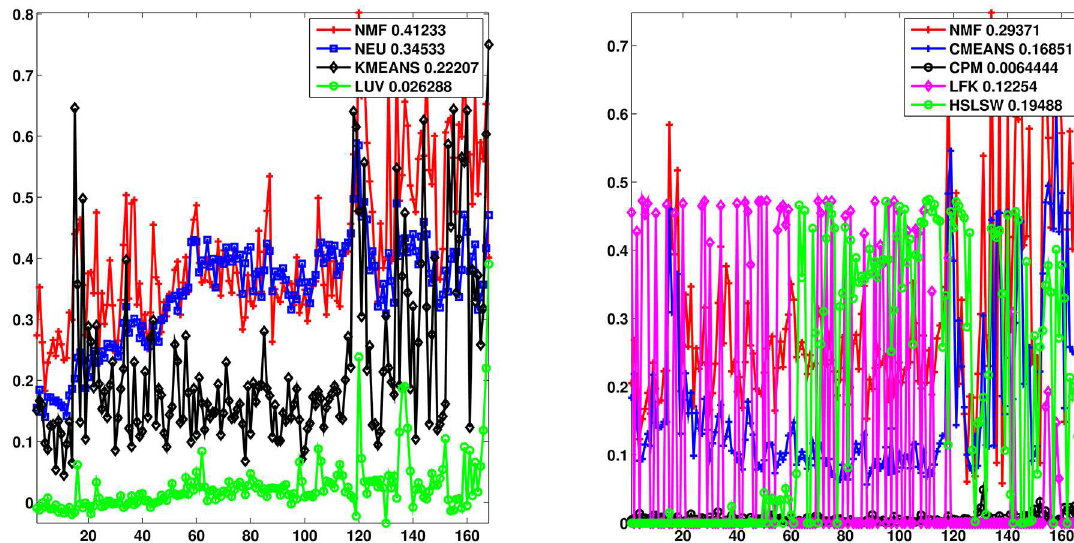
Fig 6. The modularity comparison with different algorithms. The modularityof different algorithms for hard (a) and soft partition solutions(b) along time. Beside the names of each algorithmwe report the averageof the modularity values over the entire data sample. In the legends, NMF refers to our algorithm,Von Newman(NEW), K-means (KMEANS) and Louvain method (LUV) for hard partition solution.The soft partition solution of our method (NMF) is also comparedwith the C-means algorithm(CMEANS), with the Clique Percolation Method (CPM) and with the algorithmsof Lancichinetti et al. (LFW) and Huanget al. (HSLSW).